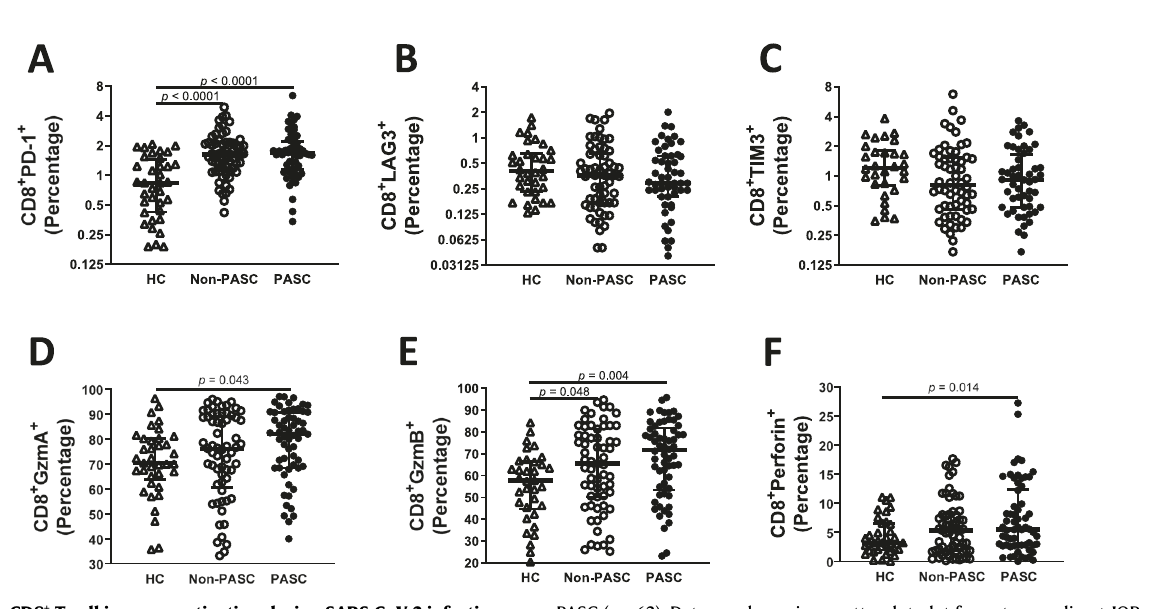
PASC ( n =62). Data are shown in a scatter dot plot format as median ± IQR; Kruskal – Wallis test was applied to identify statistical differences followed by Dunn ’ s multiple comparisons